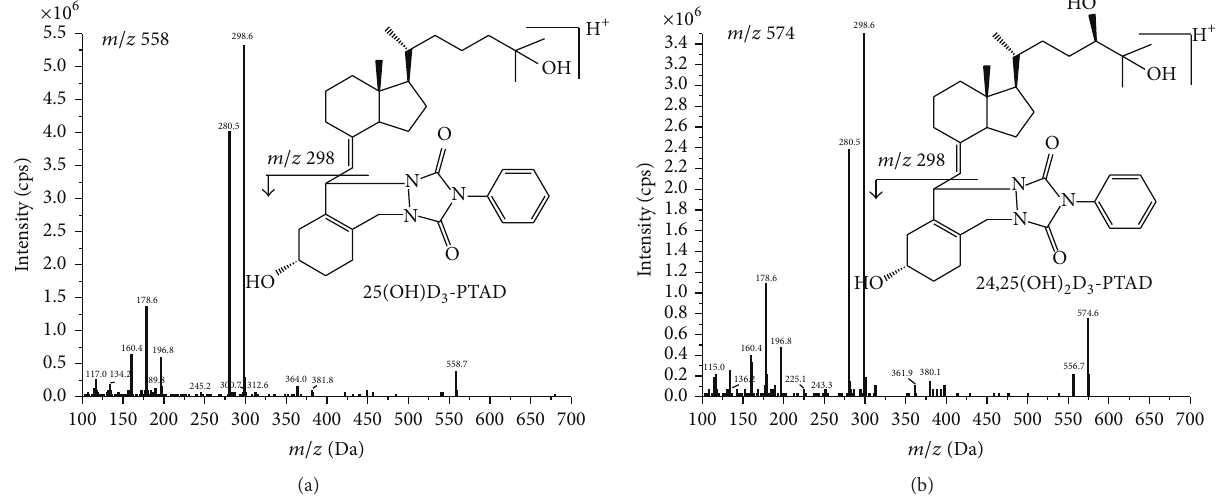
Figure 4: Production mass spectra of 25(OH)D 3 -PTAD (a) and 24,25(OH) 2 D 3 -PTAD